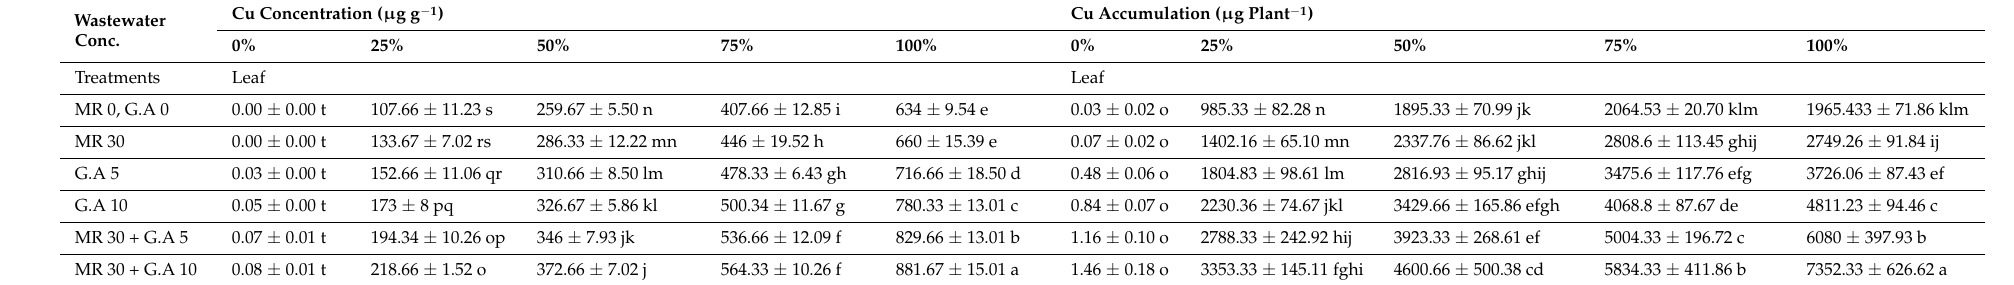
Table 2. Effect of surgical and textile effluent alone and/or in combination with GA on heavy metals uptake ( µ g g − 1 ) and accumulation ( µ g plant − 1 ) in microwave-treated and -untreated